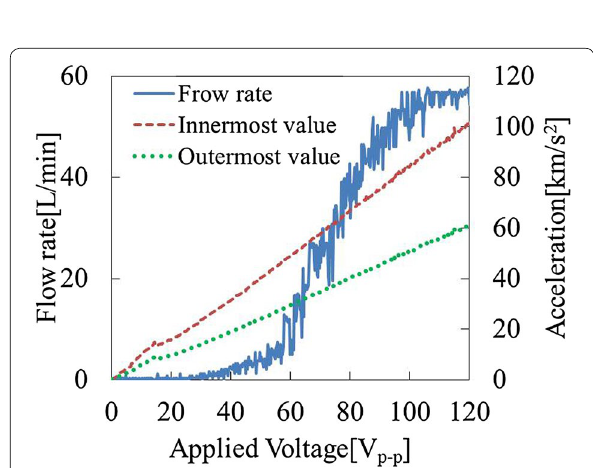
Fig. 16 Relationship between flow rate and